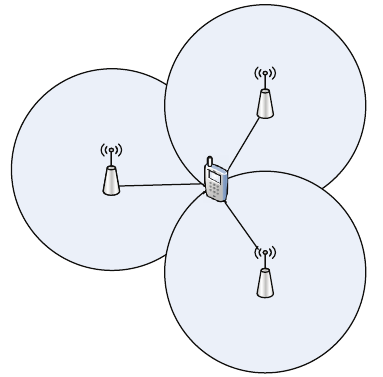
Figure 5: Positioning based on TOA/RTOF measurements.